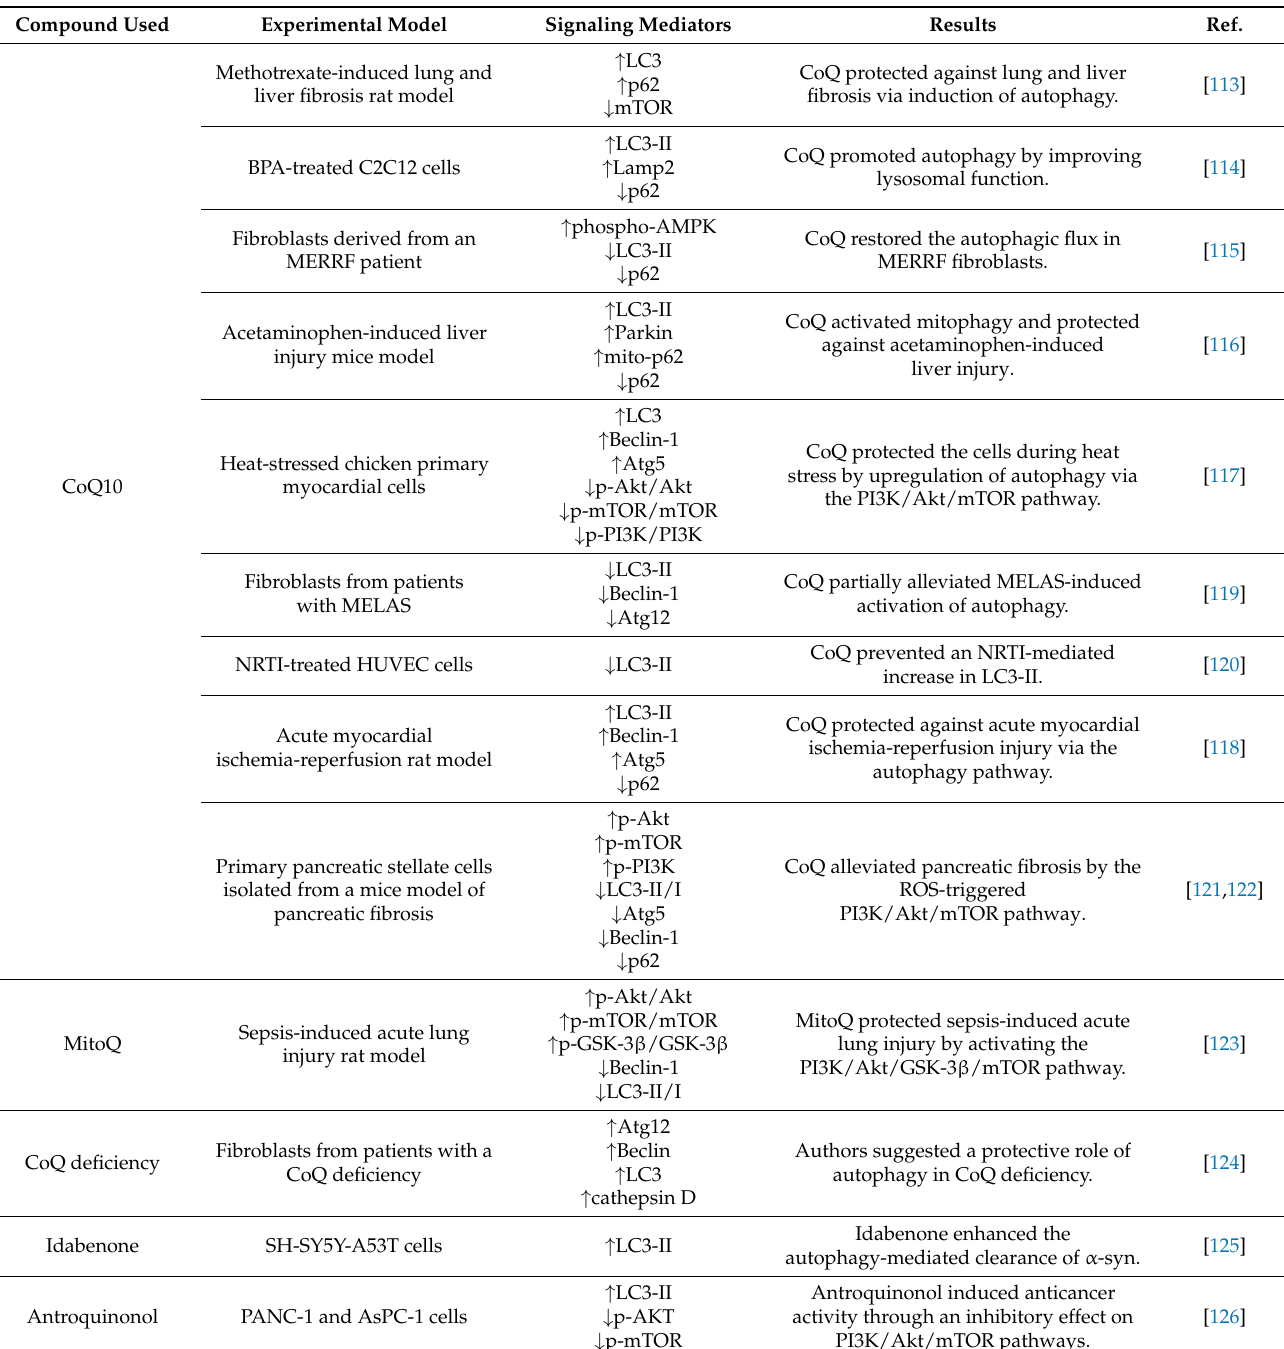
Table 5. Summary of selected available reports on the modulation of autophagy by coenzyme Q10 and its